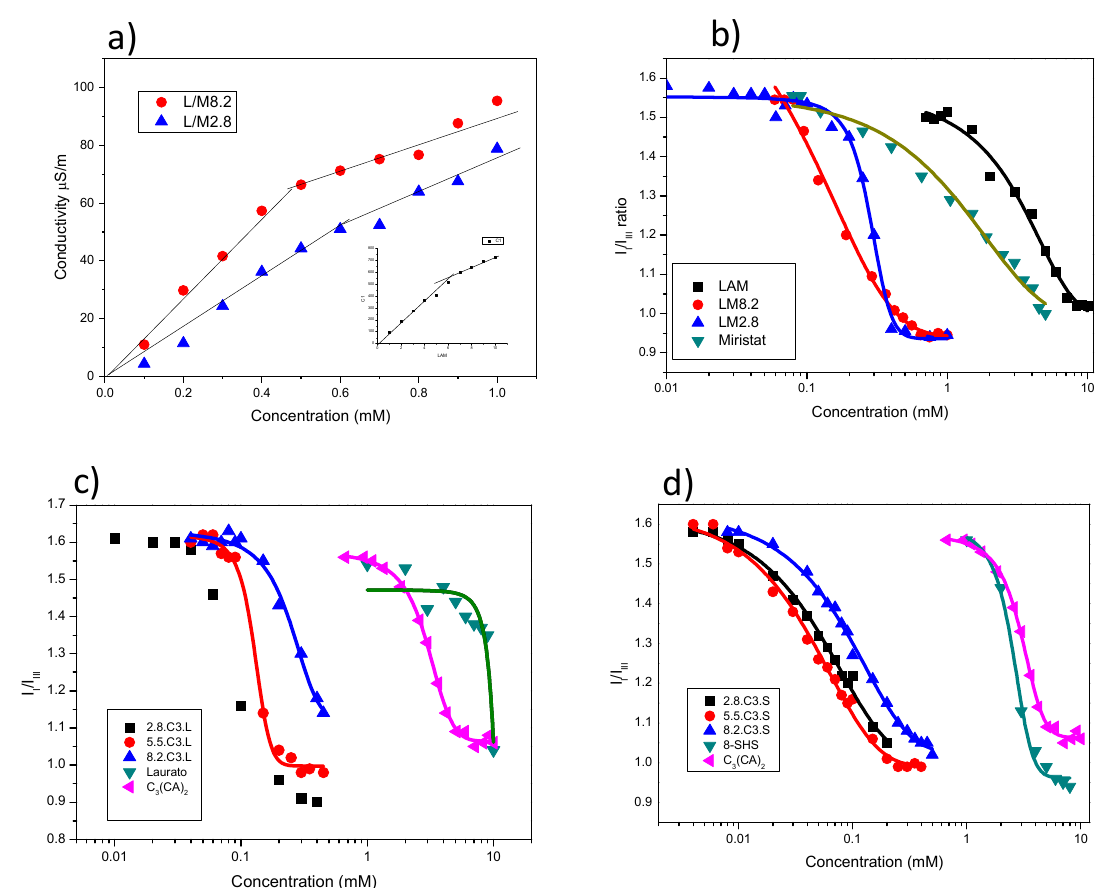
Figure 3. ( a ) Conductivity against concentration for LAM and LM mixtures, ( b ) Fluorescence measurements of LAM and LM mixtures, ( c ) Fluorescence measurements of C 3 (CA) 2 , sodium laurate and their corresponding catanionic mixtures, and ( d ) Fluorescence spectra against concentration for C 3 (CA) 2 , 8-SH and their catanionic mixtures. Table 2. Critical aggregation concentration (cac) of pure surfactants and their catanionic mixtures.